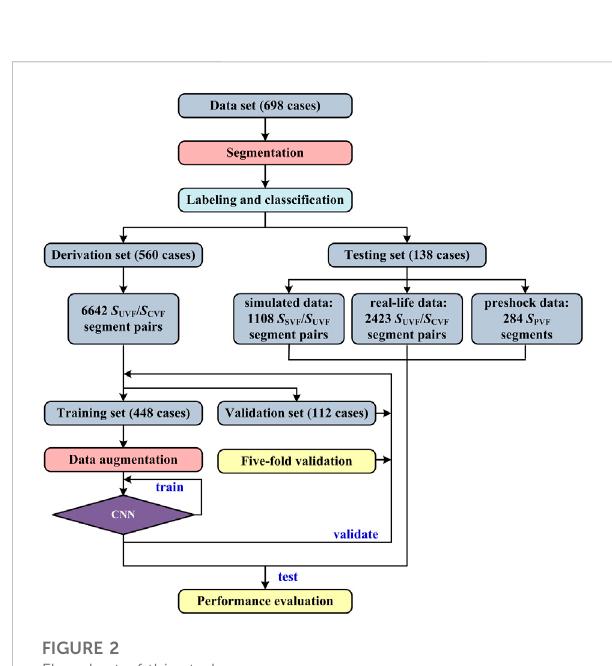
ProcessanddifferenttypesofECGsegmentextraction. (A) 8-sVFsignalsincluding4swithCCandadjacent4swithoutCC. (B) 8-sVFsignalswithout CC. (C) 4-s ECG segment during CC when the underlying rhythm was asystole. (D) 4-s VF signals without CC prior to de fi brillation